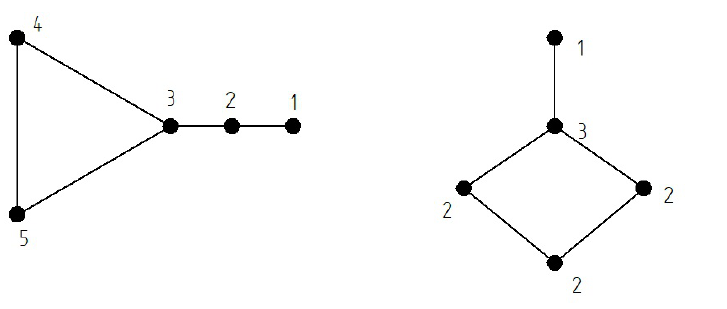
Fig. 1 Graphs with the same